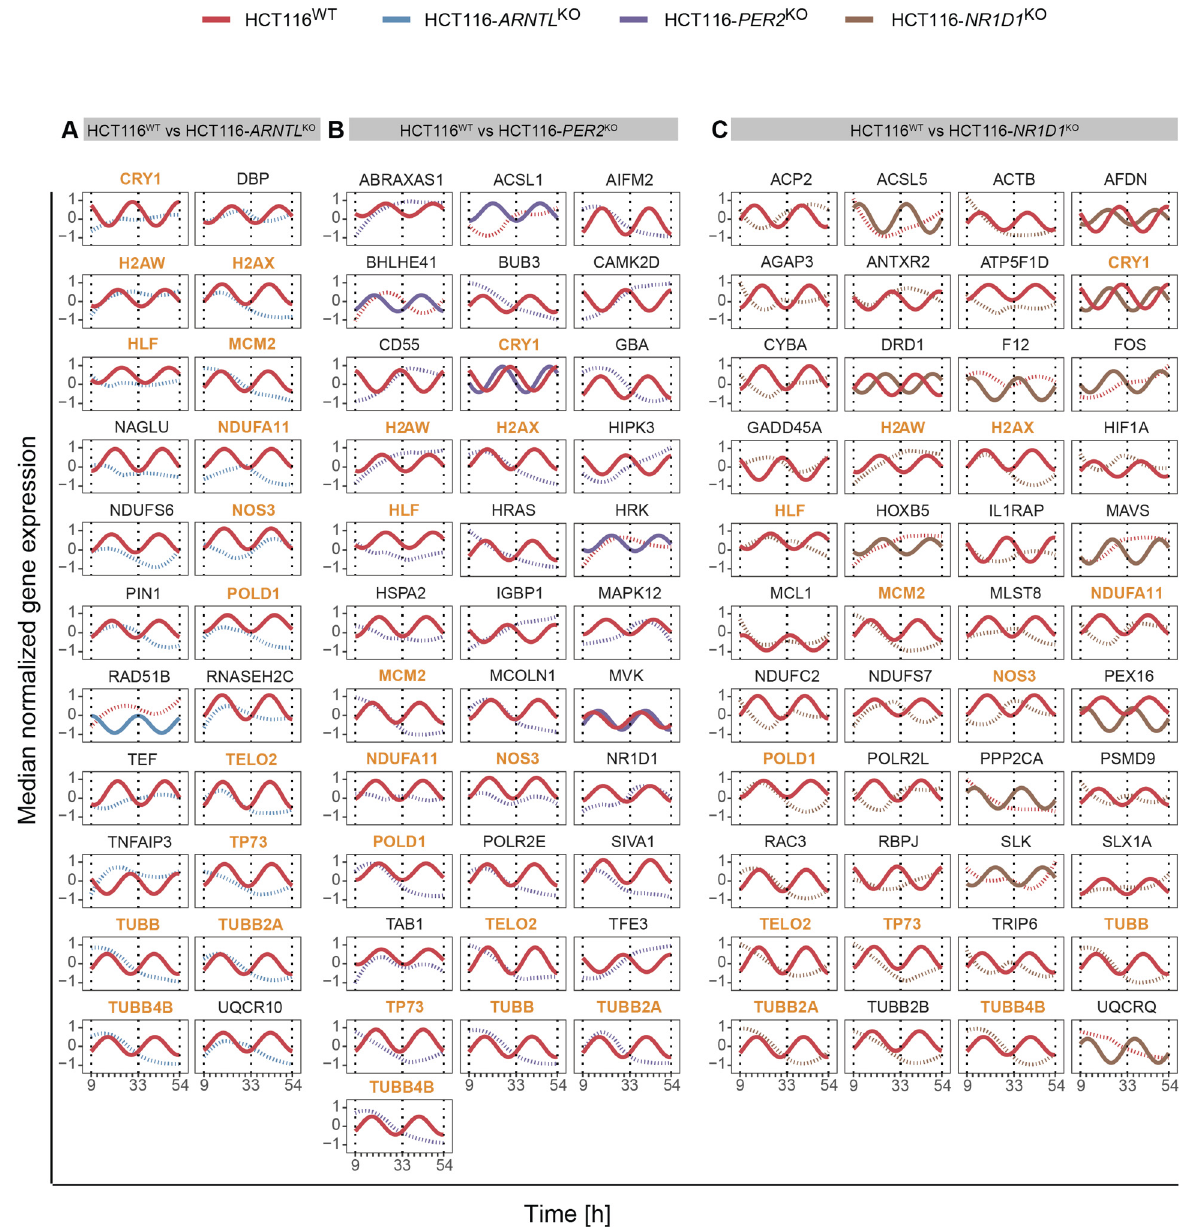
Figure 3. Circadian expression profiles of genes of interest detected as differentially rhythmic in all HCT116 KOs. ( A ) in HCT116 WT and HCT116- ARNTL KO ( B ) in HCT116 WT and HCT116- PER2 KO ( C ) in HCT116 WT and HCT116- NR1D1 KO . Significantly rhythmic genes ( q < 0.05; relative amplitude ≥ 0.1) are depicted using a harmonic regression curve (full lines); not significantly rhythmic genes are depicted with LOESS (Locally Estimated Scatterplot Smoothing) (dashed lines) (see Figure S3 for similar analysis in SW480 and SW620 cells). Common differentially rhythmic genes across all KO cells, as compared to the WT, are marked in orange.